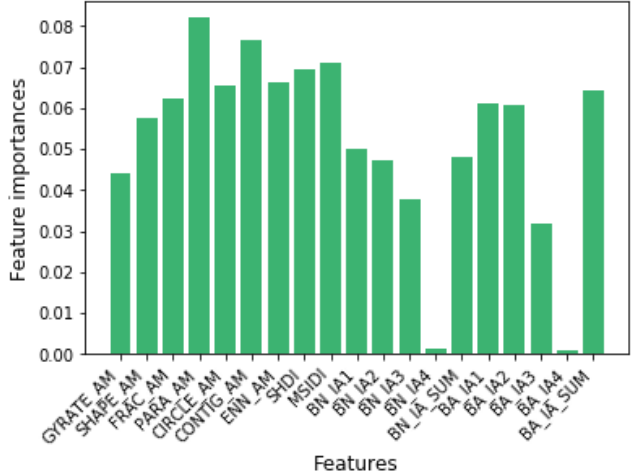
Figure 6. Average feature importance values for landscape-level metrics and building-based indexes in the random forest classifier.